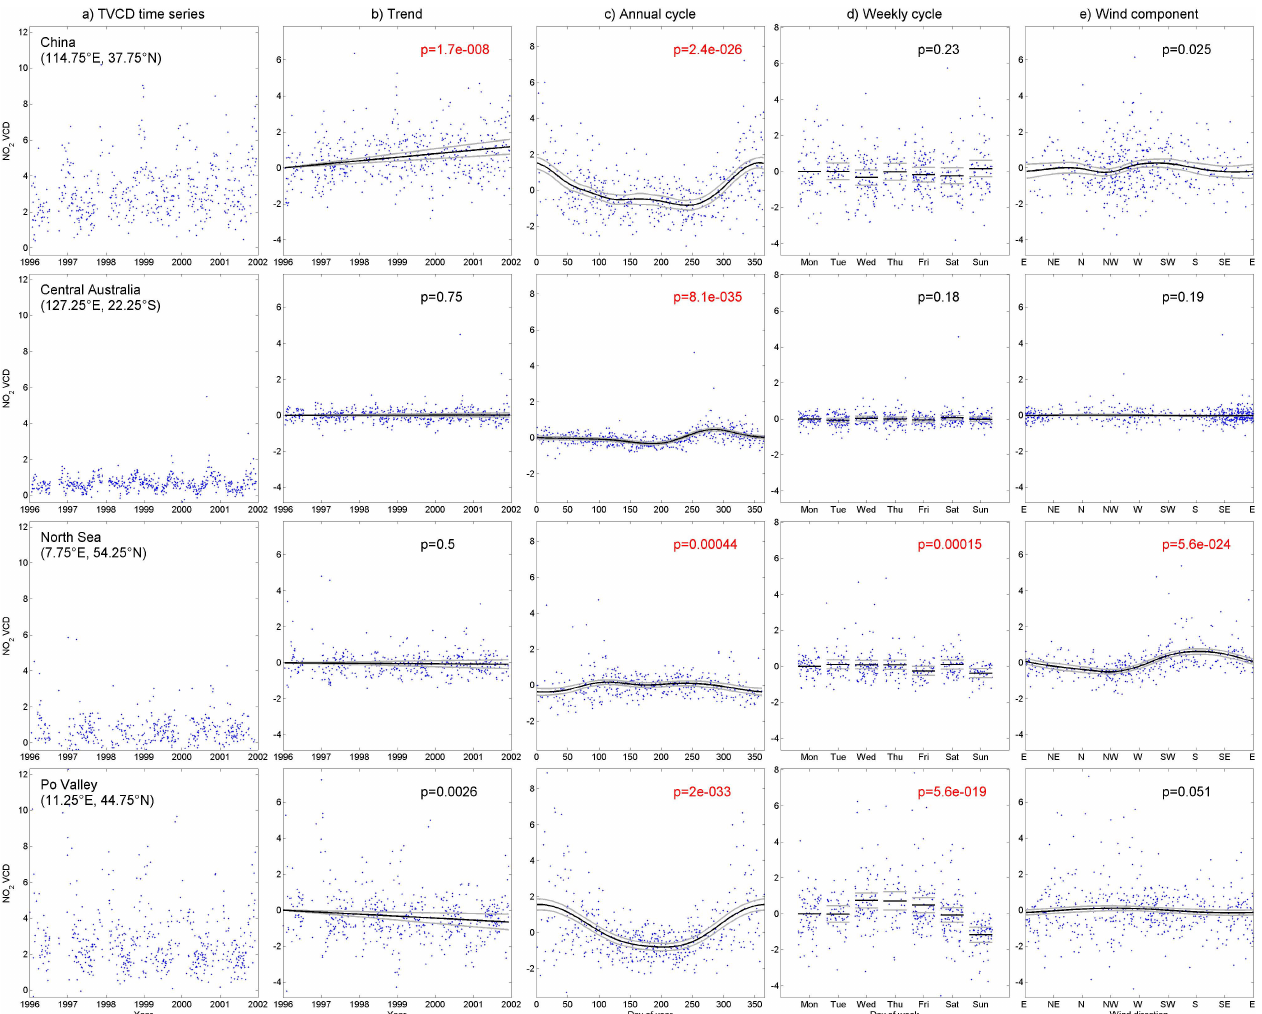
Fig. 2. Examples of the GAM components for China, Central Australia, the North Sea, and the Po Valley. (a) The original TVCD time series. (b) The trend component. (c) The annual cycle. (d) The weekly cycle. (e) The wind component. The dots in (b–e) illustrate the individual measurements corrected for all other GAM components. The numbers give the GAM p -values, indicating the significance of the respective component. p -values below 1‰ are considered as significant and marked in